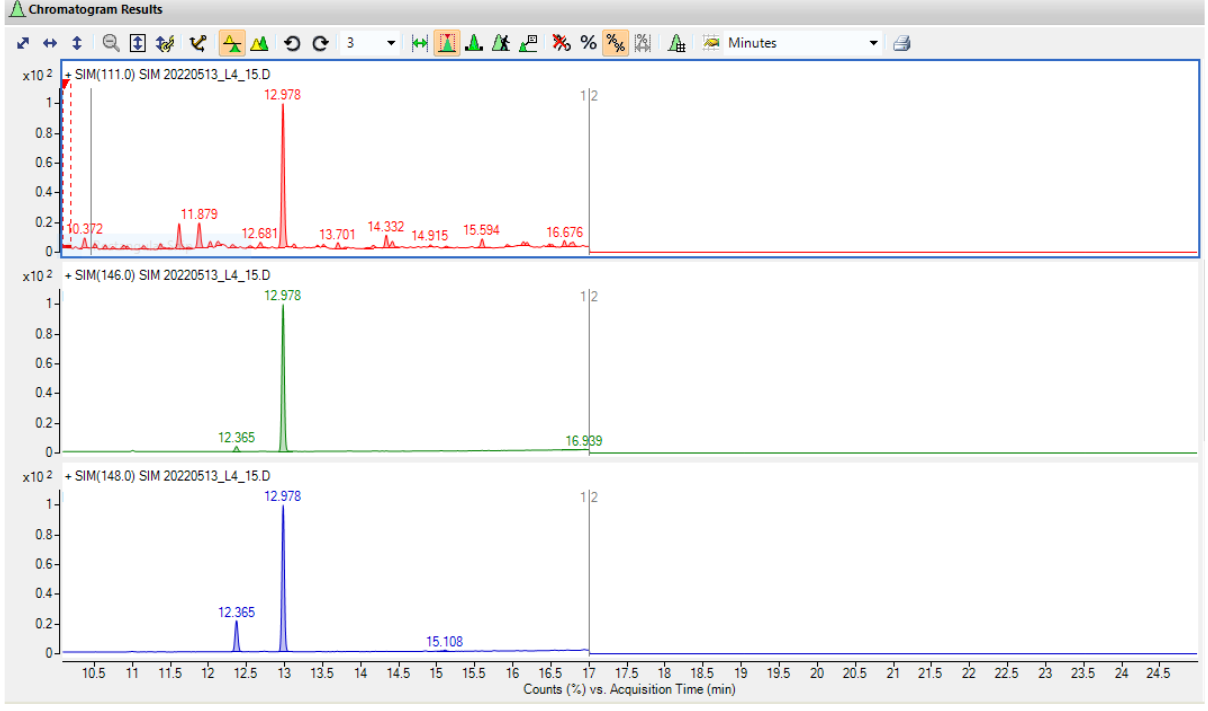
Figure A1. Chromatogram (SIM mode) of PDCB in beeswax. Quantitation ion m/z 146 and qualita- tive ions m/z 111 and 146.